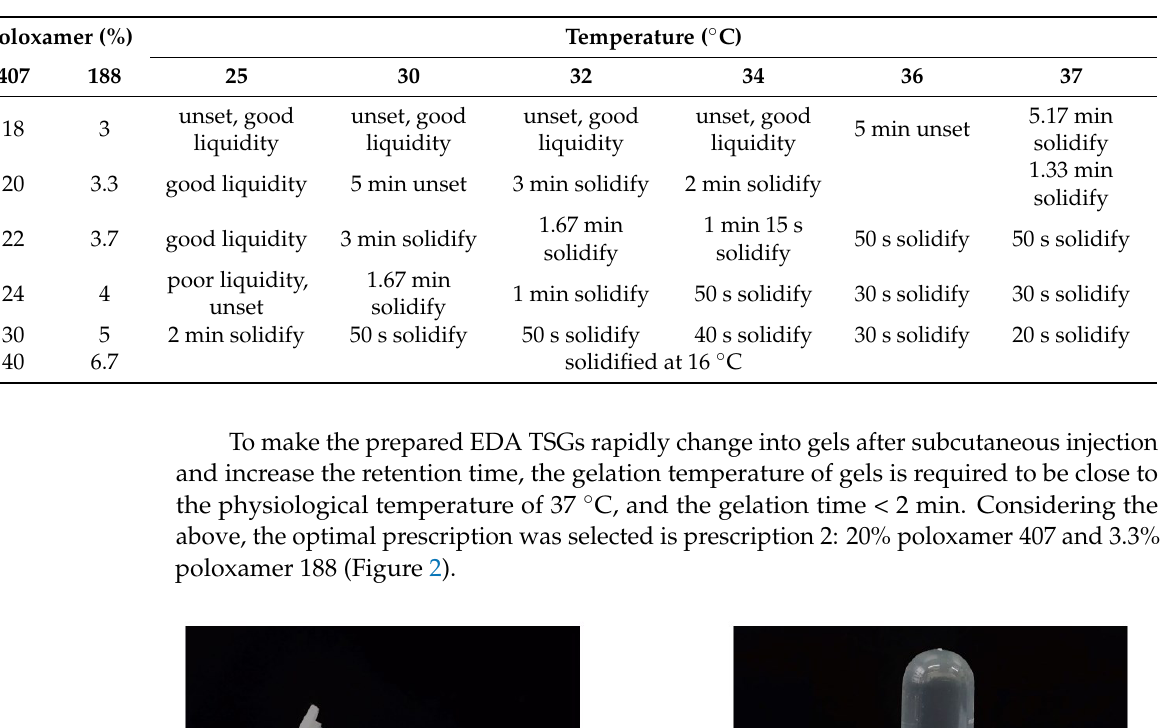
Table 1. Evaluation of gels with different prescriptions at different temperatures.